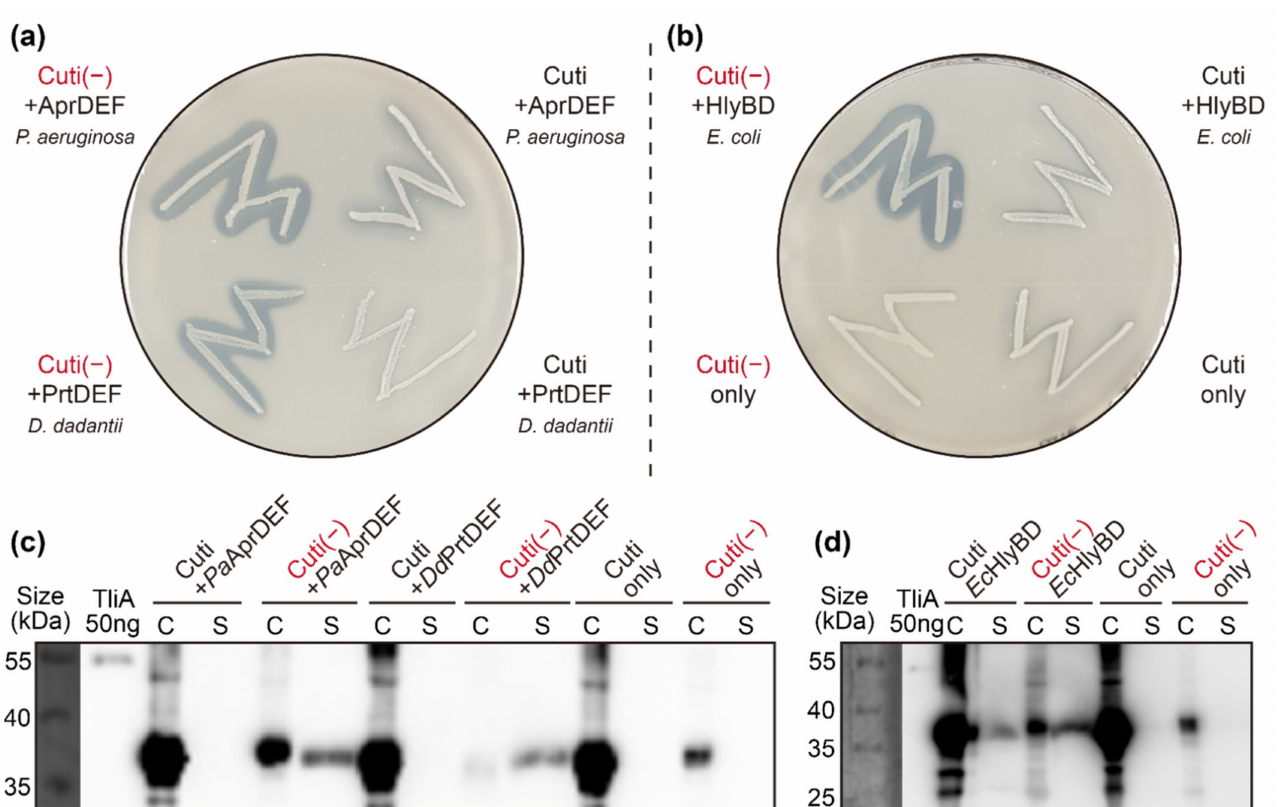
Figure 8. The effect of cargo protein supercharging in the other ABC transporters. E. coli XL1- Blue was double-transformed with two plasmids, one expressing cutinase variants and the other expressing the polypeptide-secreting ABC transporter. Empty vector without ABC transporter was used as the negative control. The colonies were screened from LB agar plates containing 50 µ g/mL of carbenicillin and 100 µ g/mL of chloramphenicol, then streaked on LB agar plates containing 0.5% colloidal tributyrin. ( a , b ) The three different ABC transporters, Pa AprDEF, Dd PrtDEF, and Ec HlyBD + TolC complexes, successfully secreted the negatively supercharged cutinase (Cuti( − )). They secreted much less wild-type cutinase (Cuti). This could be clearly seen from the halo size comparisons. ( c , d ) The supercharged and wild-type versions of cutinase were tested for secretion via the three different polypeptide-secreting ABC transporters. In these Western blots, both the cell pellet (labeled “C”) and the culture supernatant (labeled “S”) samples were analyzed in